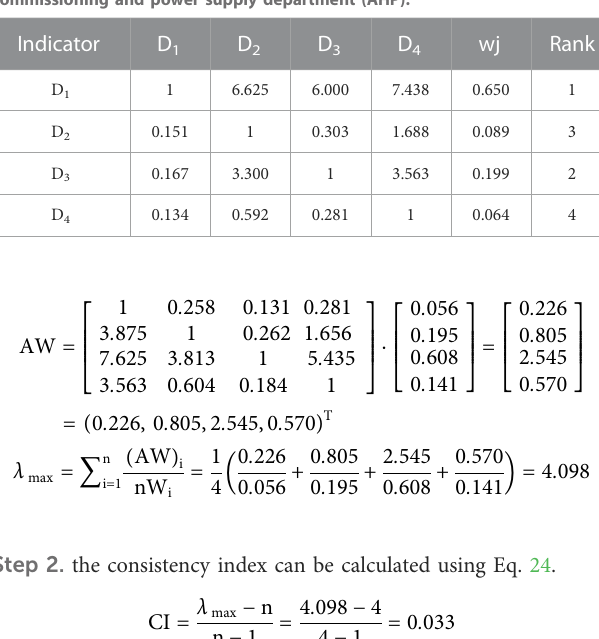
TABLE 18 Pairwise comparison matrix of installation construction factor layer (AHP). Indicator